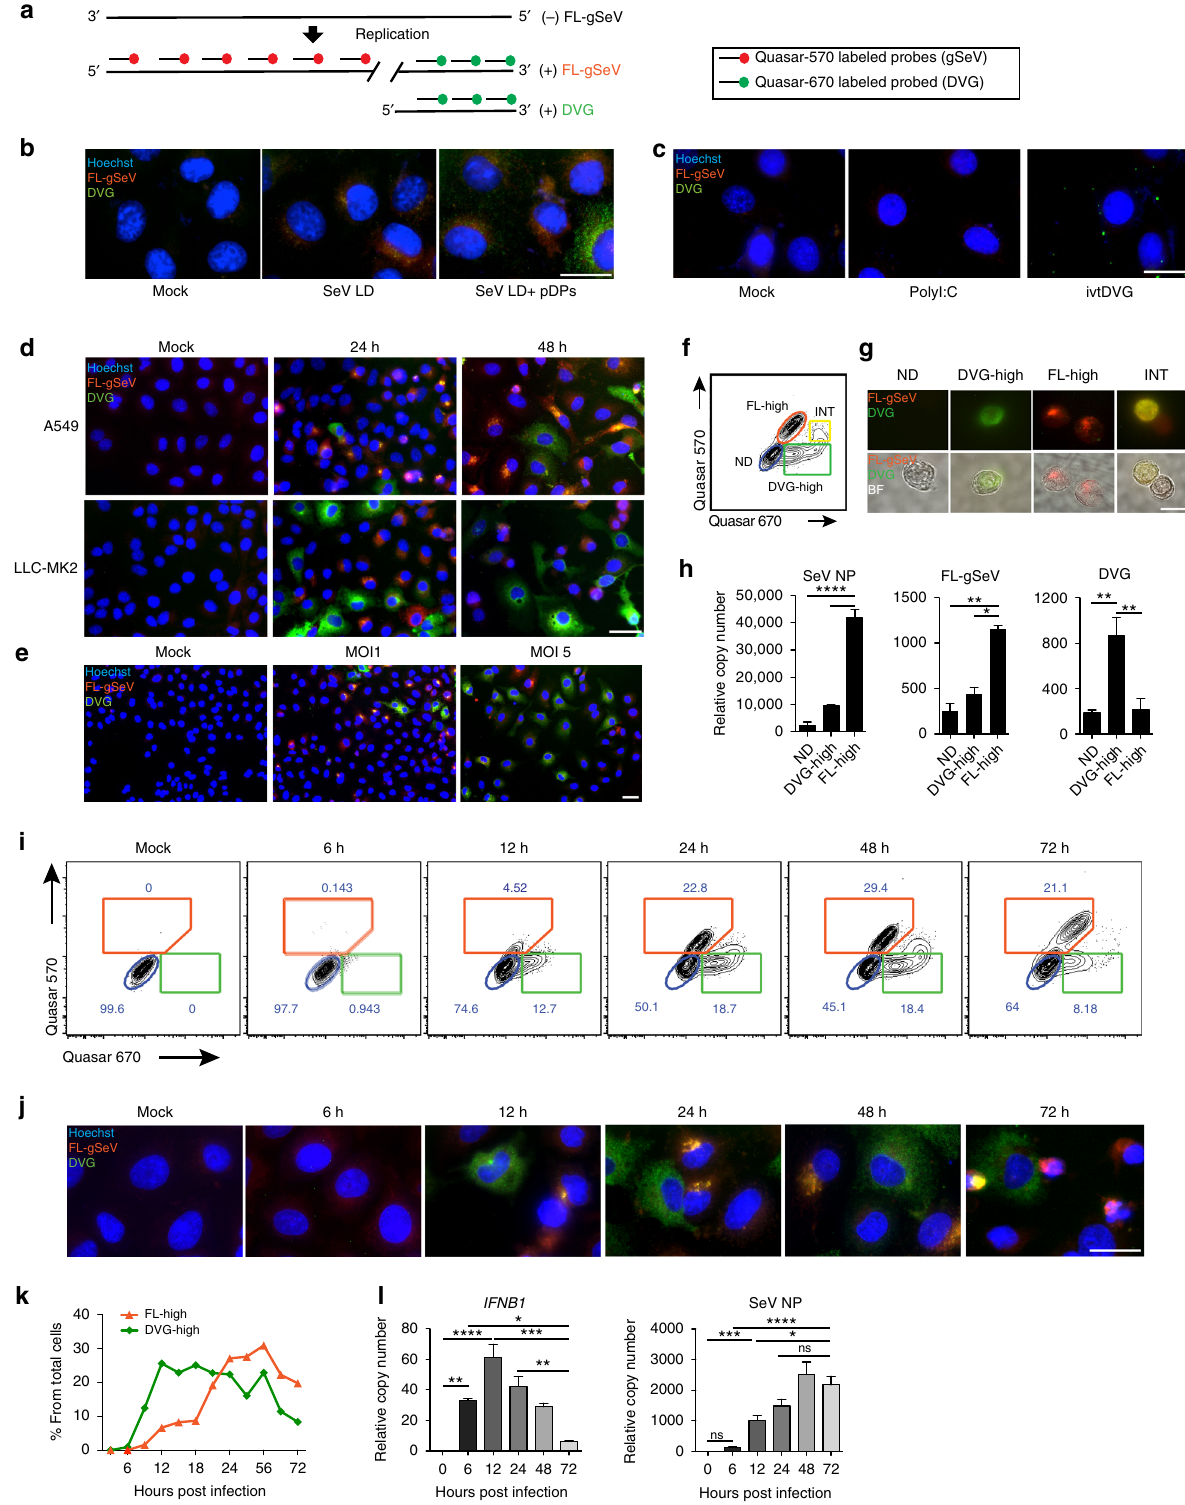
and were passaged for at least 17 days (Fig. 2a, b and Supple- mentary Fig. 2a). Remarkably, a substantially higher proportion of DVG-high cells survived by day 5 post SeV HD infection compared to FL-high cells (Fig. 2a), and by day 17 post infection ∼ 34% of the total survivors were DVG-high